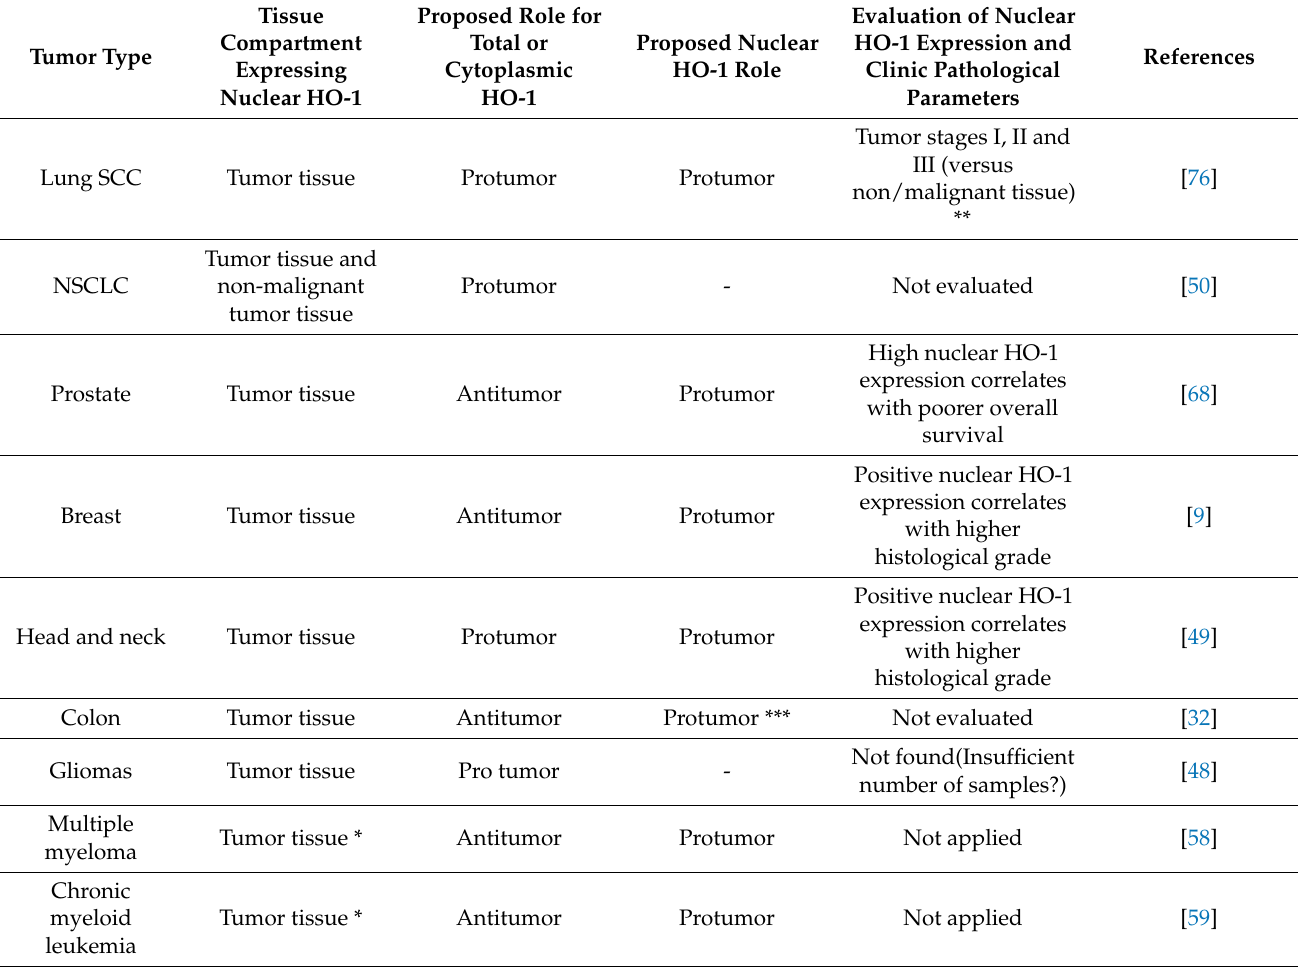
Table 1. Evidence showing nuclear HO-1 expression in